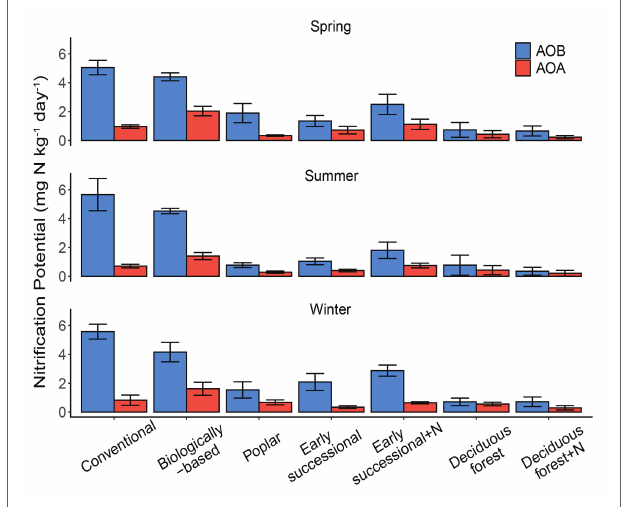
FIGURE 1 | AOA (orange) and AOB (blue)-derived seasonal nitrification potentials in systems varying in management intensities; bars represent standard error ( n = 4 field replicates except for deciduous forest n = 2–3). “+N” indicates subplots receiving N fertilizer. No significant differences among seasons were detected ( p =